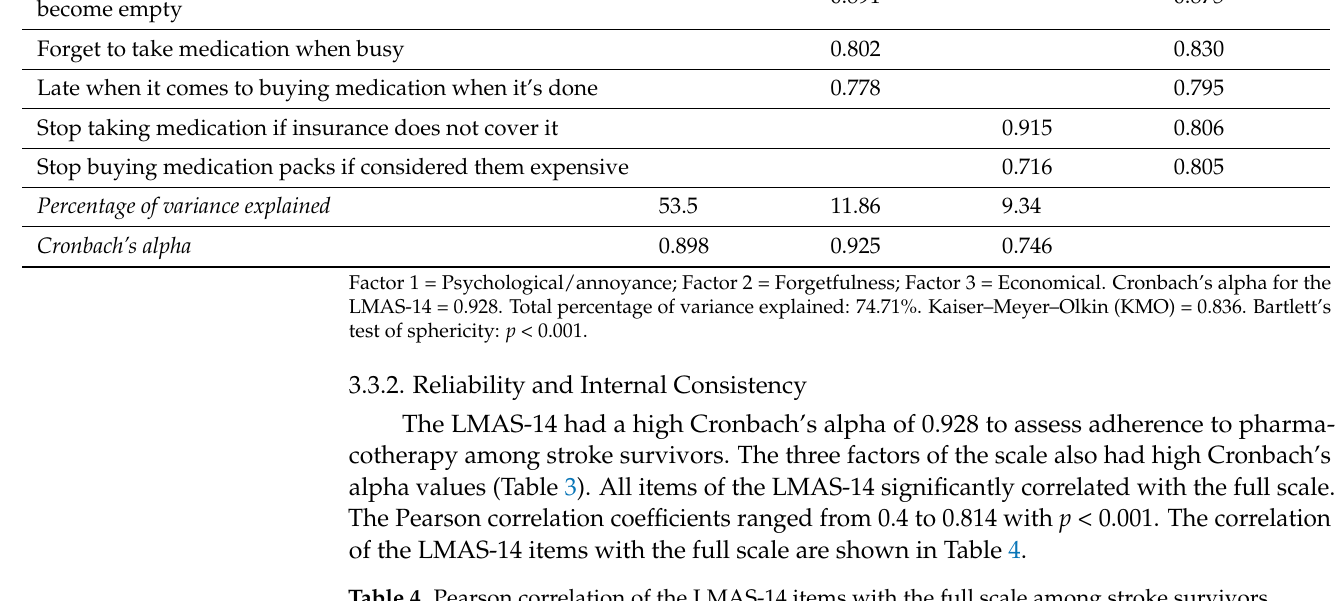
Table 4. Pearson correlation of the LMAS-14 items with the full scale among stroke